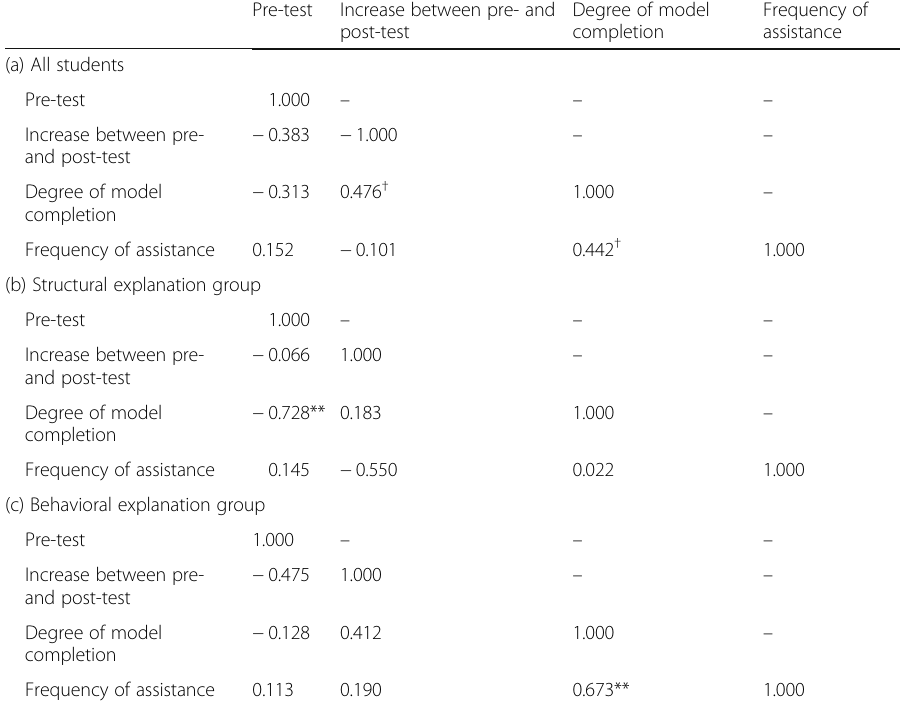
Table 2 Result of correlation analysis